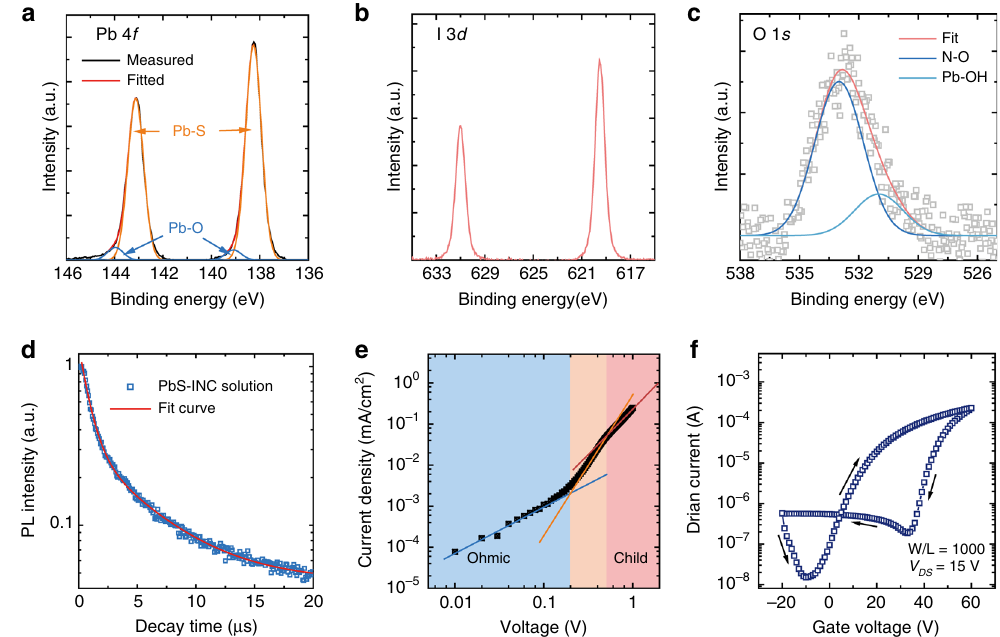
Fig. 3 X-ray Photoelectron Spectrum (XPS) and optoelectronic properties. a Pb 4 f XPS spectrum, b I 3 d XPS spectrum and c O 1 s XPS spectrum of PbS-I NCs. d Transient photoluminescence of PbS-I NC solution. e J-V curve of space charge limited current device of PbS-I NCs. Device structure: Ag/PbS-I/Ag.